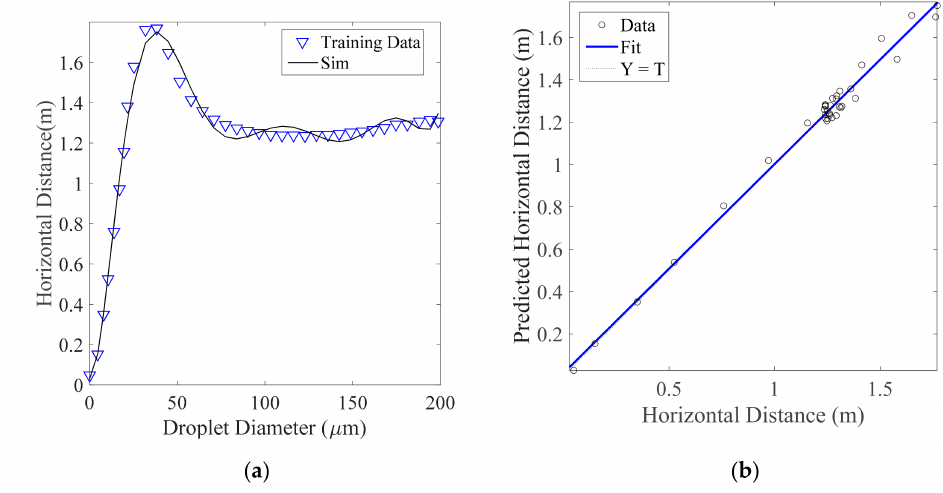
Figure 11. The horizontal distance prediction compared to the numerical model as a function of droplet diameter ( a ) and the training correlation ( b